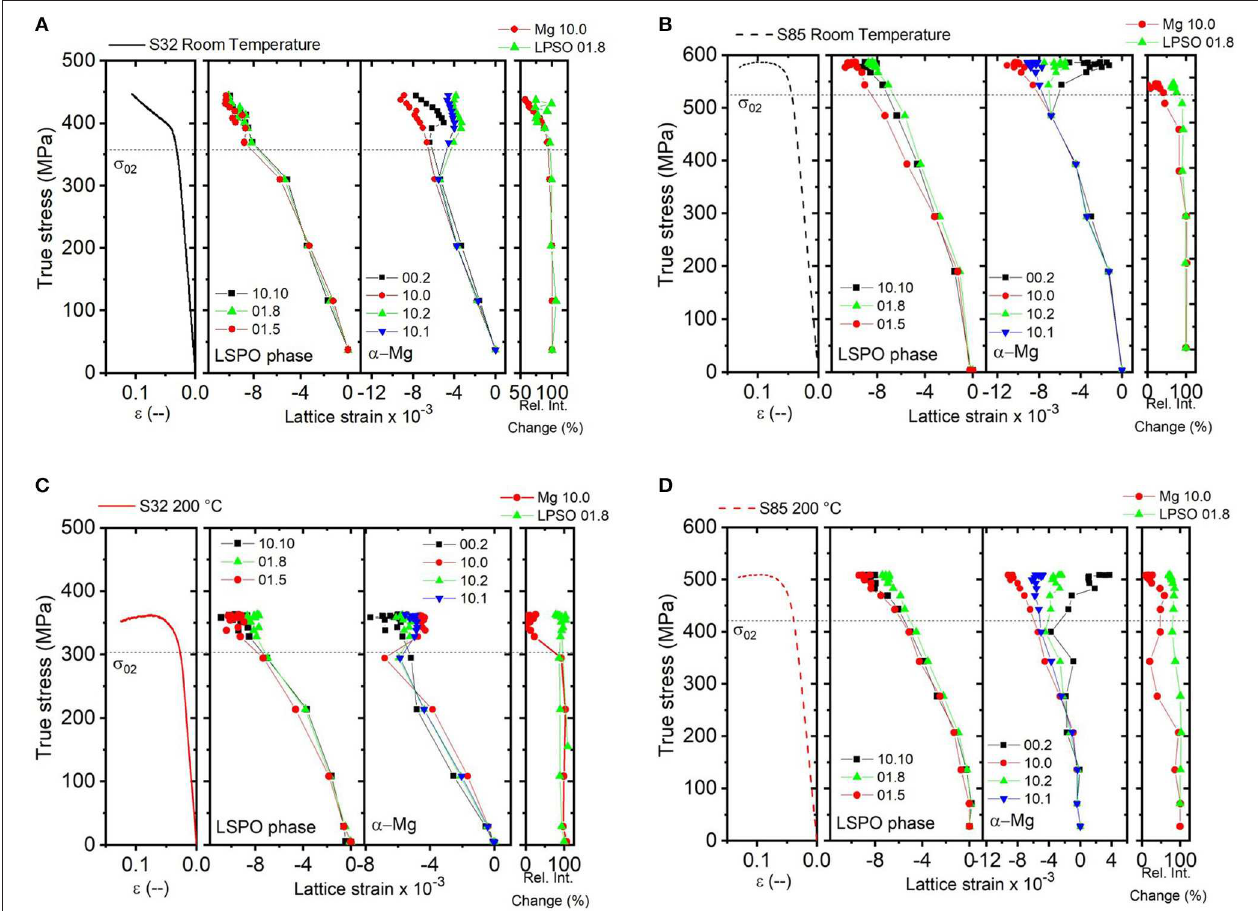
FIGURE 6 | Macroscopic stress-strain curves, the axial lattice strains as a function of the applied stress and evolution of the intensity of the major diffracted peaks of the α -Mg and LPSO phase during compression loading of the S32 and S85 alloy at RT (A,B) and at 200 ◦ C ( C,D , respectively).